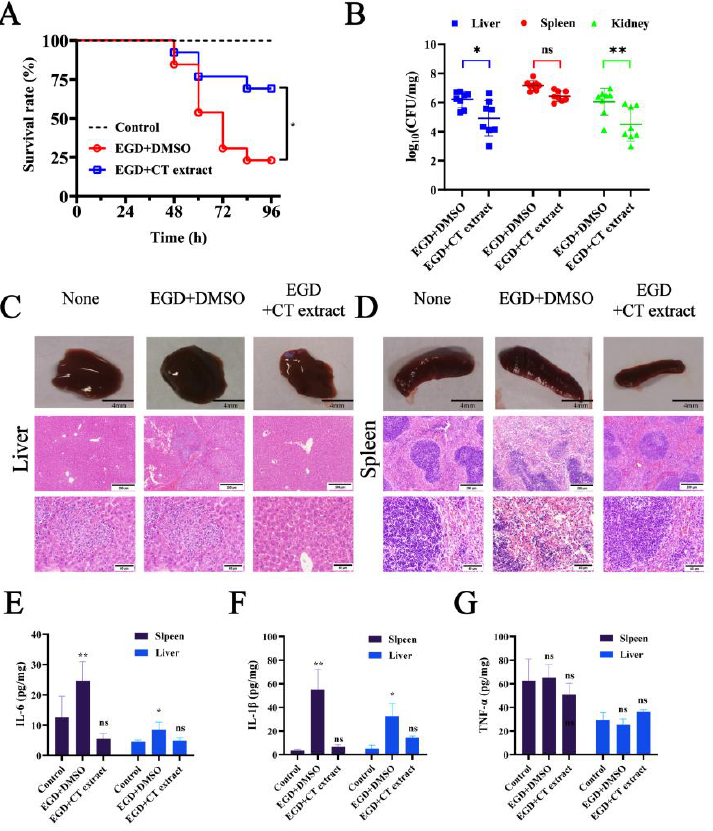
Figure 6. CT extract protects mice from L. monocytogenes infection. ( A ) Survival analysis of infected or uninfected mice treated with CT extract. Mice were infected with lethal doses of L. monocytogenes EGD and observed every 12 h. ( B ) Bacterial burden in liver and spleen determined within 48 h after infection in control (non-CT extract-treated) and CT extract-treated groups. Data are expressed as the means ± SEM. p values were calculated using one-tailed Mann – Whitney test (** p < 0.01). Histo- pathological analysis of livers ( C ) and spleens ( D ) from untreated mice infected with L. monocyto- genes EGD with or without CT extract treatment was determined after 48 h infection. These images were collected from the representative stained sections, with the original magnification being 10 × (the scale length is 200μm) and 40 × (the scale length is 40μm), respectively. Cytokines of IL -6 ( E ), IL- 1β ( F ) and TNF- α ( G ) in supernatants were examined using ELISAs. All the data are expressed as means ± S.D. (n ≥ 5). ** p < 0.01.